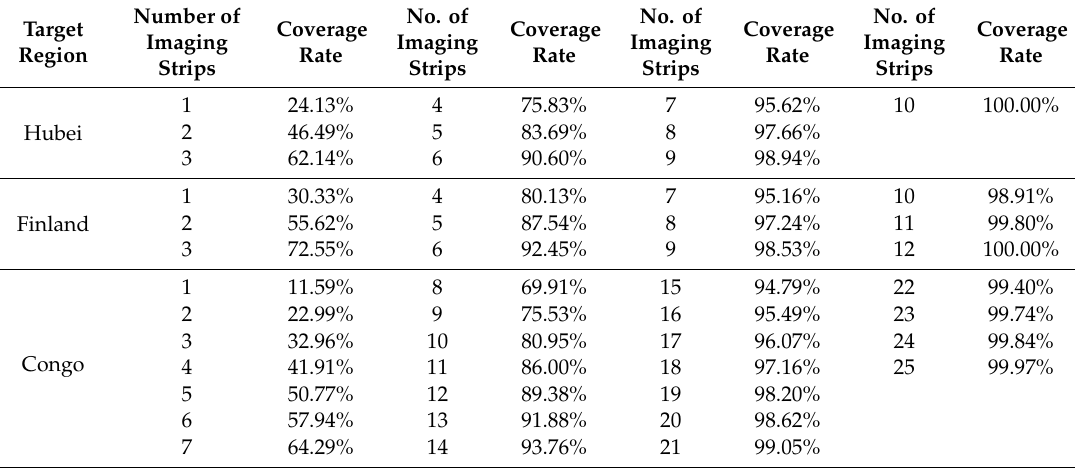
Table 7. Di ff erent satellite imaging planning schemes determined using the multi-objective optimization model proposed in this paper. Target